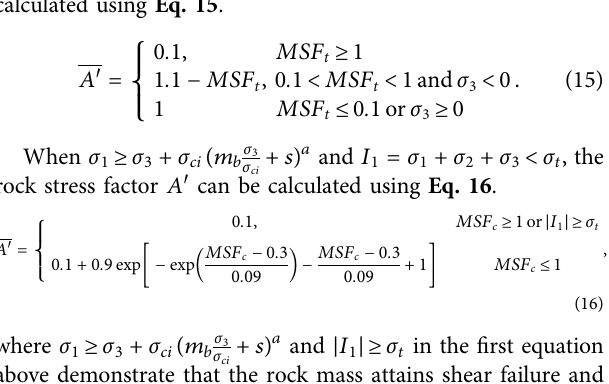
Frontiers in Earth Science |